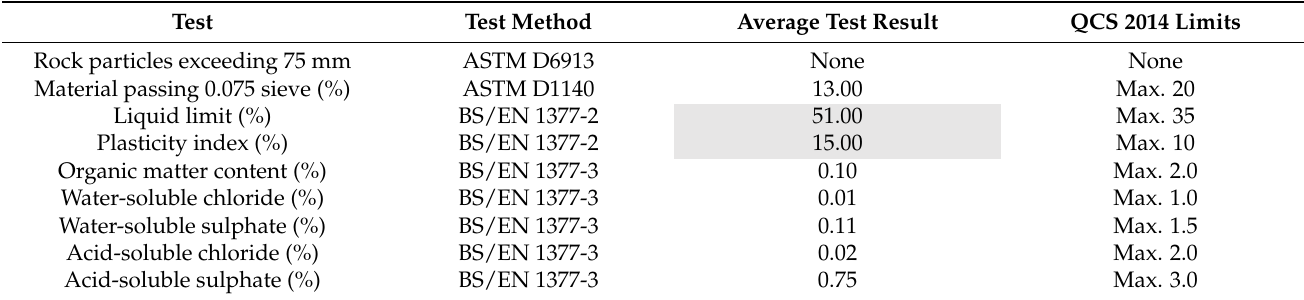
Table 4. Comparison between the properties of TBM muck and QCS 2014 (specifications of suitable filling material related to buildings).